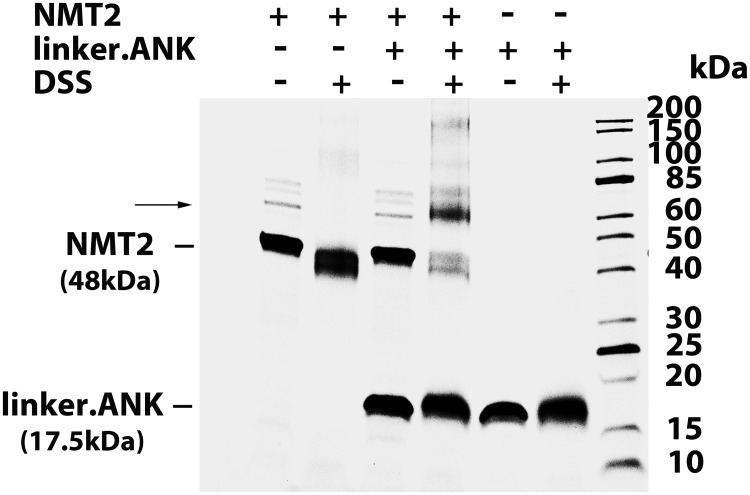
The C-terminal module is sufficient for NMT2 interaction.NMT2 (10μM) and the linker.ANK (30μM) recombinant protein were dialyzed together at 4°C for 16 hours. As indicated, the proteins were then reacted with the DSS reagent (1.2mM) for 2 hours at 4°C. Reactions were stopped by quenching with a solution of 100mM Tris-HCl pH 7.5. Proteins were separated on denaturing SDS-gradient gel (Any Kd, Bio-Rad). After electrophoresis, gel was stained with Gelcode Blue (Fisher Scientific). The panel shows the image of the gel with the position of NMT2 (48kDa), of linker.ANK (17.5kDa), and of a complex formed after treatment by DSS indicated on the left. The molecular masses of the ladder (Unstained Protein Standard, Broad Range; NewEnglandBiolabs) are shown on the right.